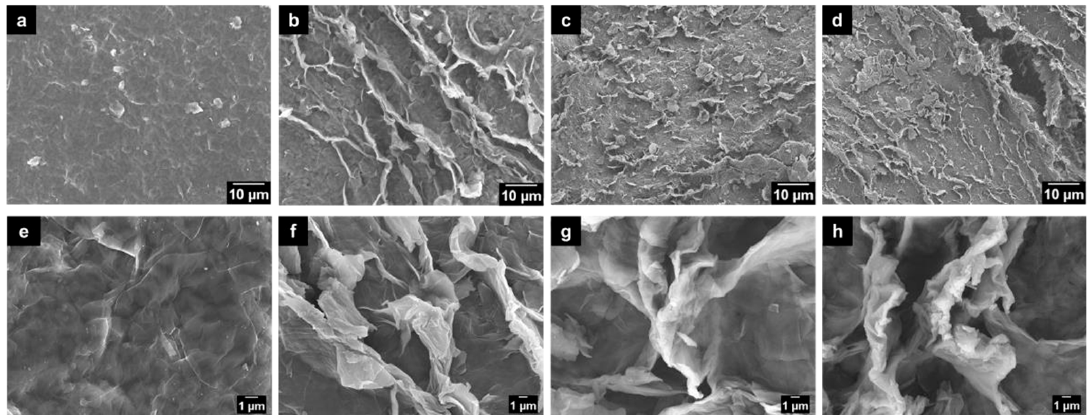
Figure 1. SEM images of ( a , e ) graphene oxide (GO), ( b , f ) GO-100, ( c , g ) GO-110 and ( d , h ) GO-120 with different magnification.